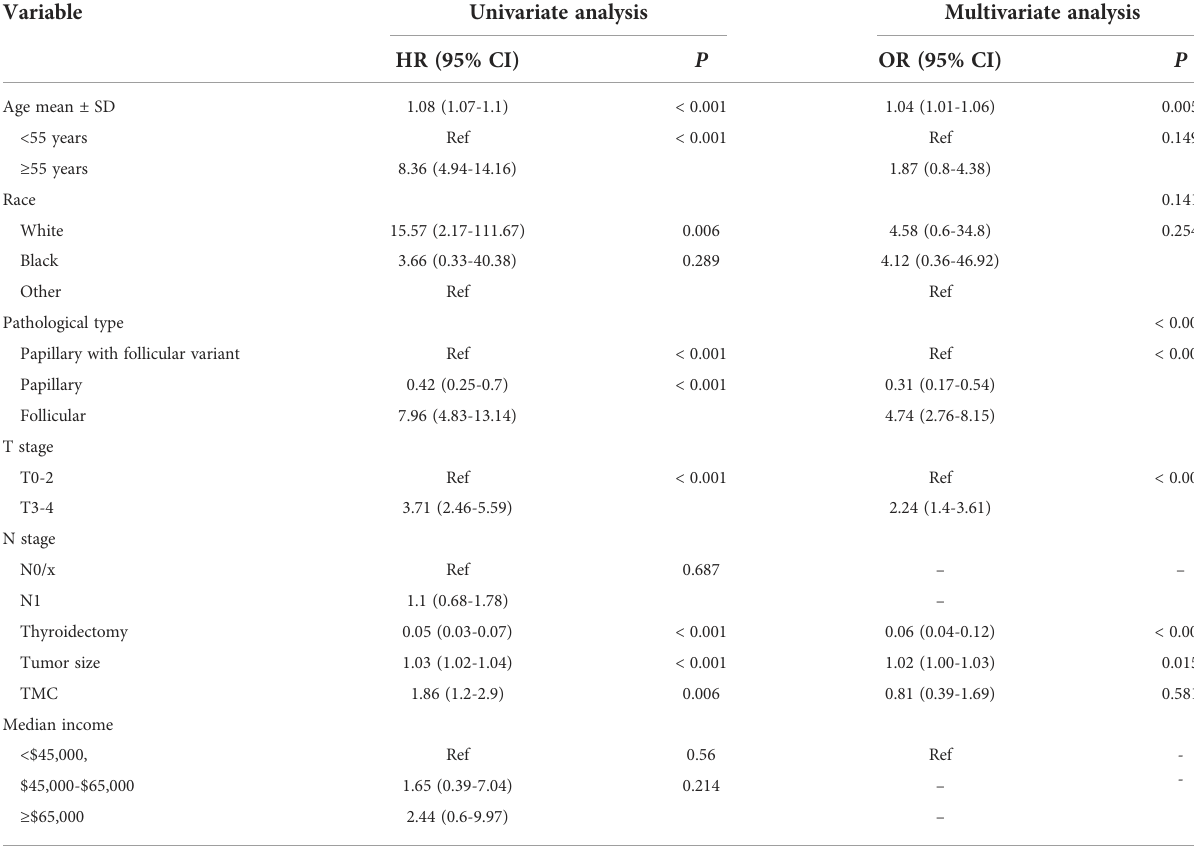
TABLE 4 Univariate and multivariate logistics regression analyses of the risk factors of bone metastasis in FDTC patients.